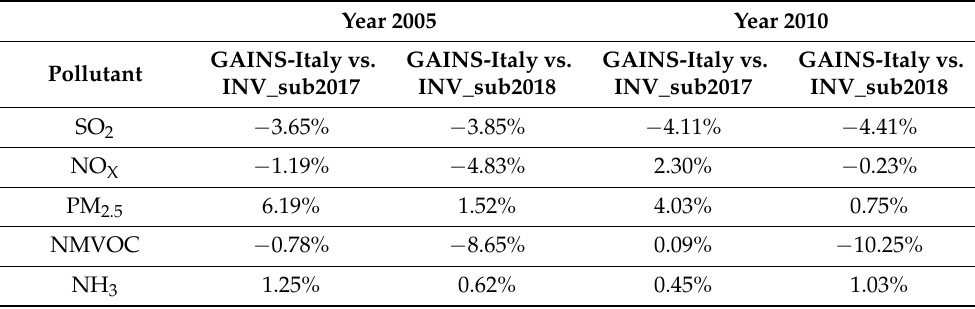
Table 5. Difference between Greenhouse Gas and Air Pollution Interactions and Synergies Model over Italy (GAINS-Italy) emission estimates and the national emission inventory submissions 2017 and 2018 (INV_sub2017 and INV_sub2018, respectively), for the years 2005 and 2010, for the five National Emission Ceilings Directive (NECD)